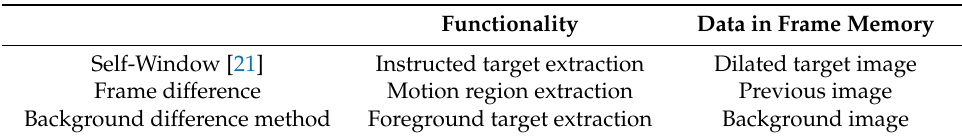
Table 2. Functions of the 1b PE.